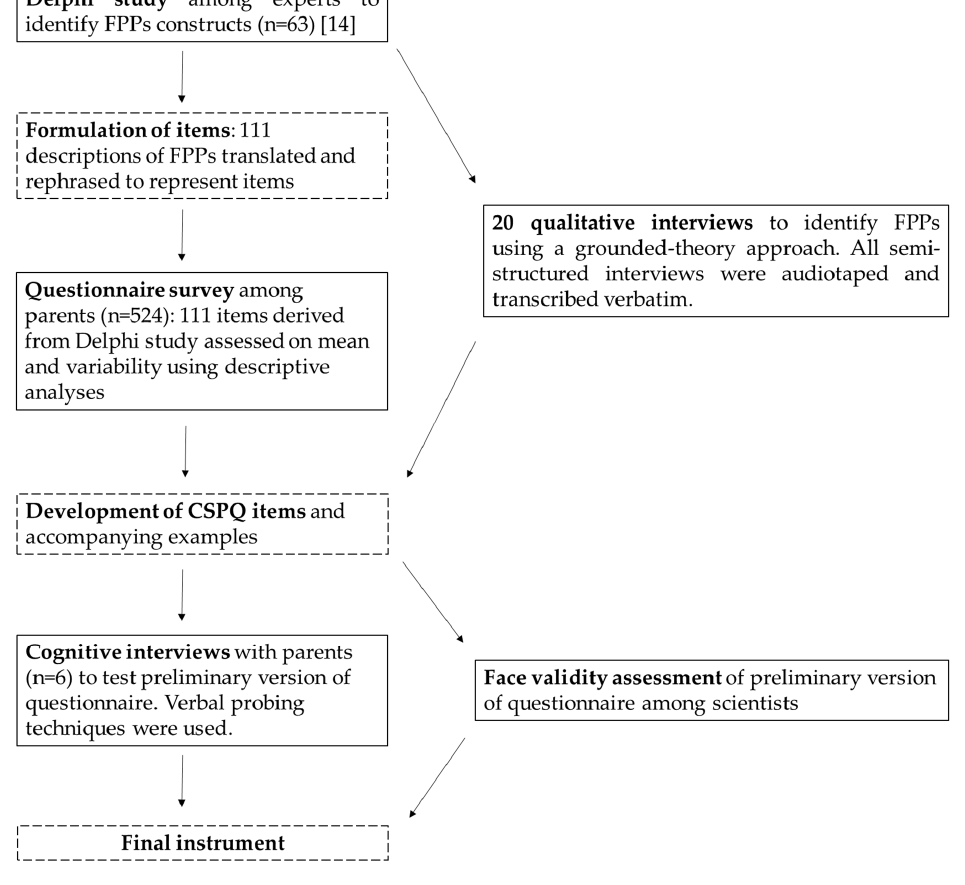
Figure 1. Flow chart of the Comprehensive Snack Parenting Questionnaire (CSPQ) development.